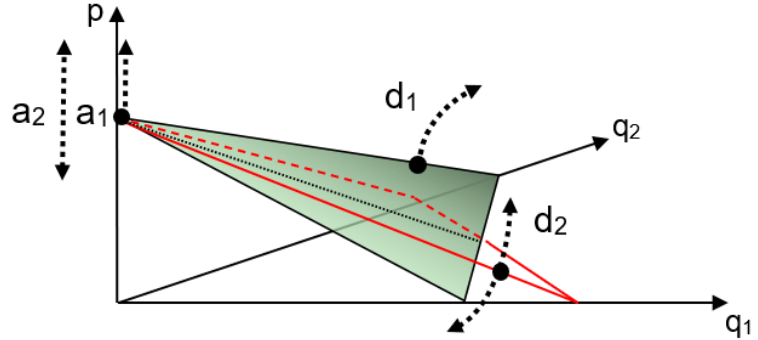
Figure 2. Impact of advertising on the indirect demand function.